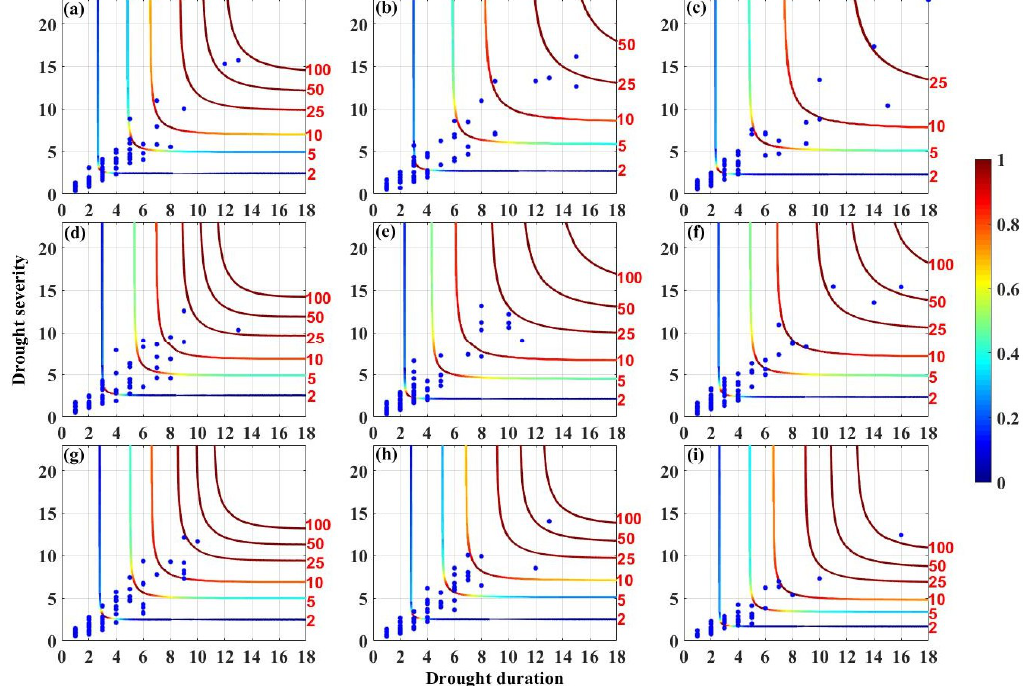
Figure 7. Drought return period isolines are color coded with joint density levels with blue representing lower densities and red denoting higher densities. Blue dots show drought events. ( a – i ) denote AL (Frank-copula), LL (Normal-copula), LH (Frank-copula), IF (Frank-copula), HL (Normal-copula), LS (Frank-copula), SH (Frank-copula), BH (Frank-copula), and YRB (Frank-copula),